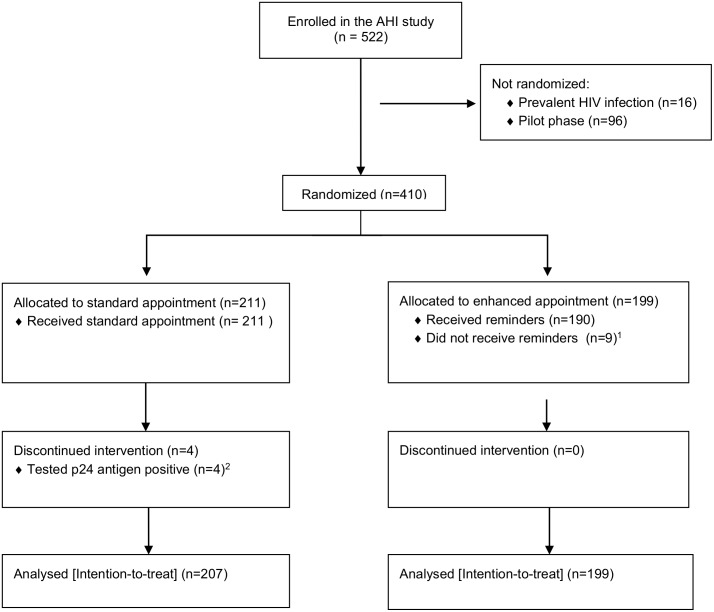
Flow of participants.1Reminders were not sent because locator forms were missing. 2Participants who tested p24 antigen positive were recalled to the clinic immediately, hence not included in the analysis of intervention effect.